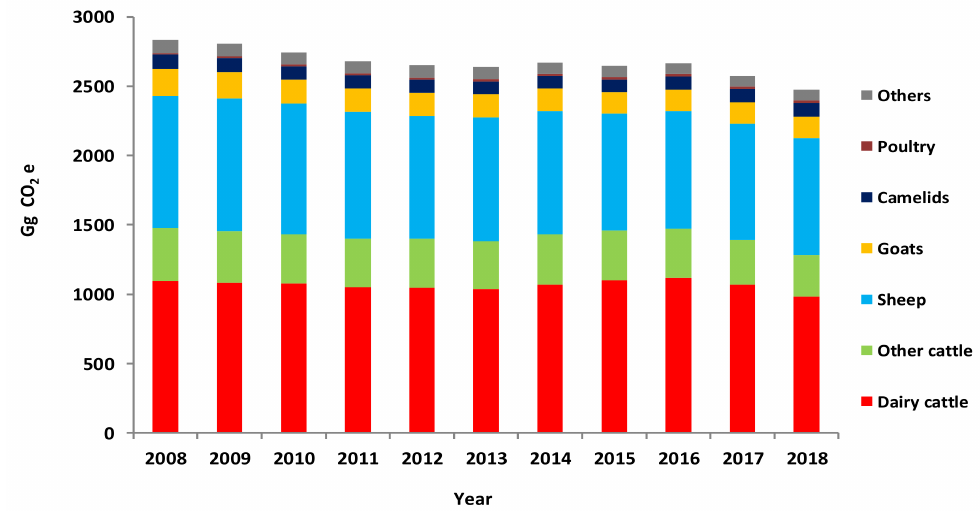
Figure 4. Evolution of total CH 4 production (Gg CO 2 e) by the di ff erent animal species / category from Tunisian livestock during the studied period